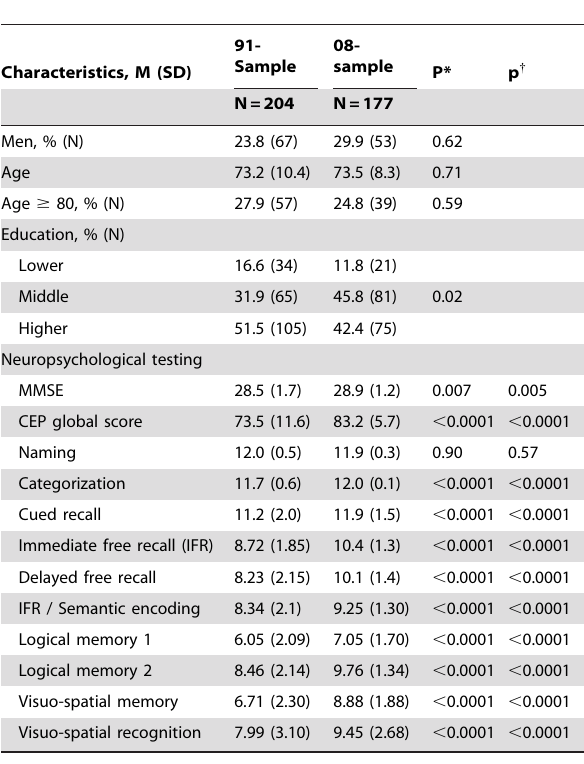
Table 1. General characteristics of the 1991- and 2008-